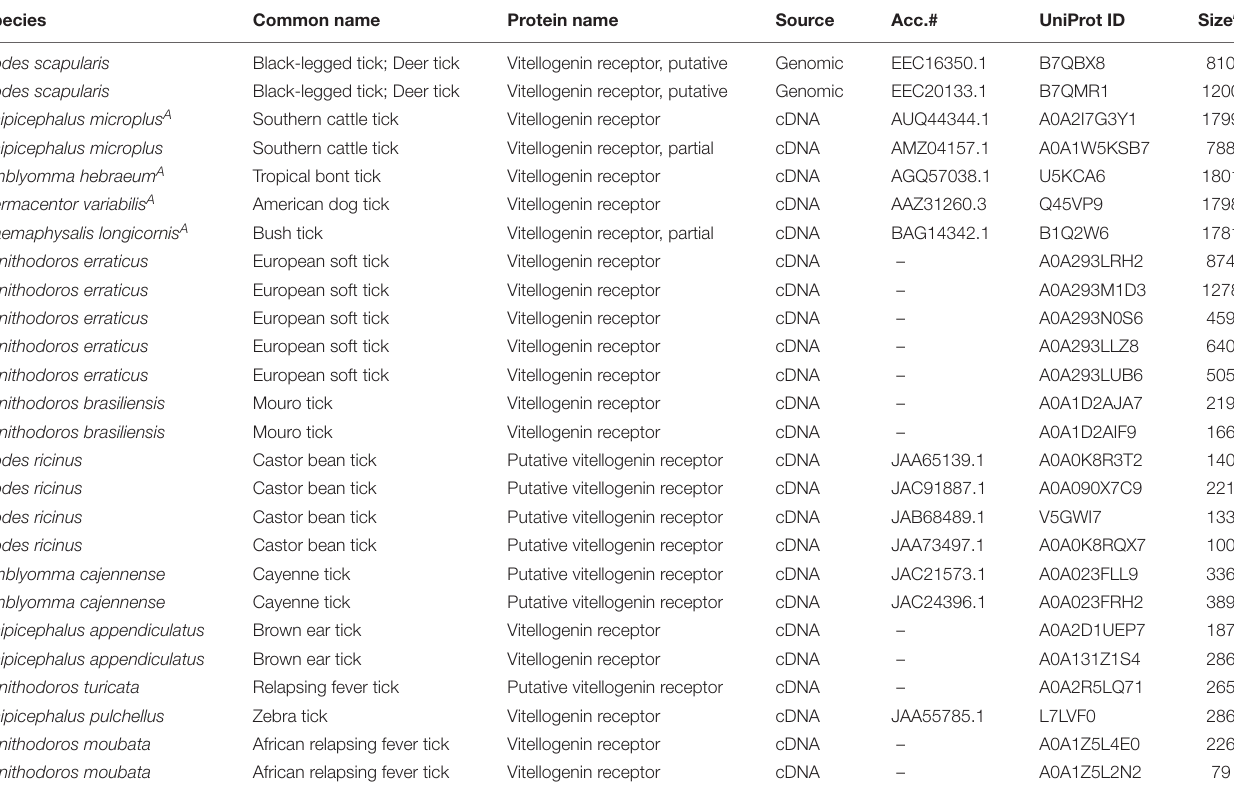
TABLE 1 | Tick vitellogenin receptor (VgR) sequence information available to date.